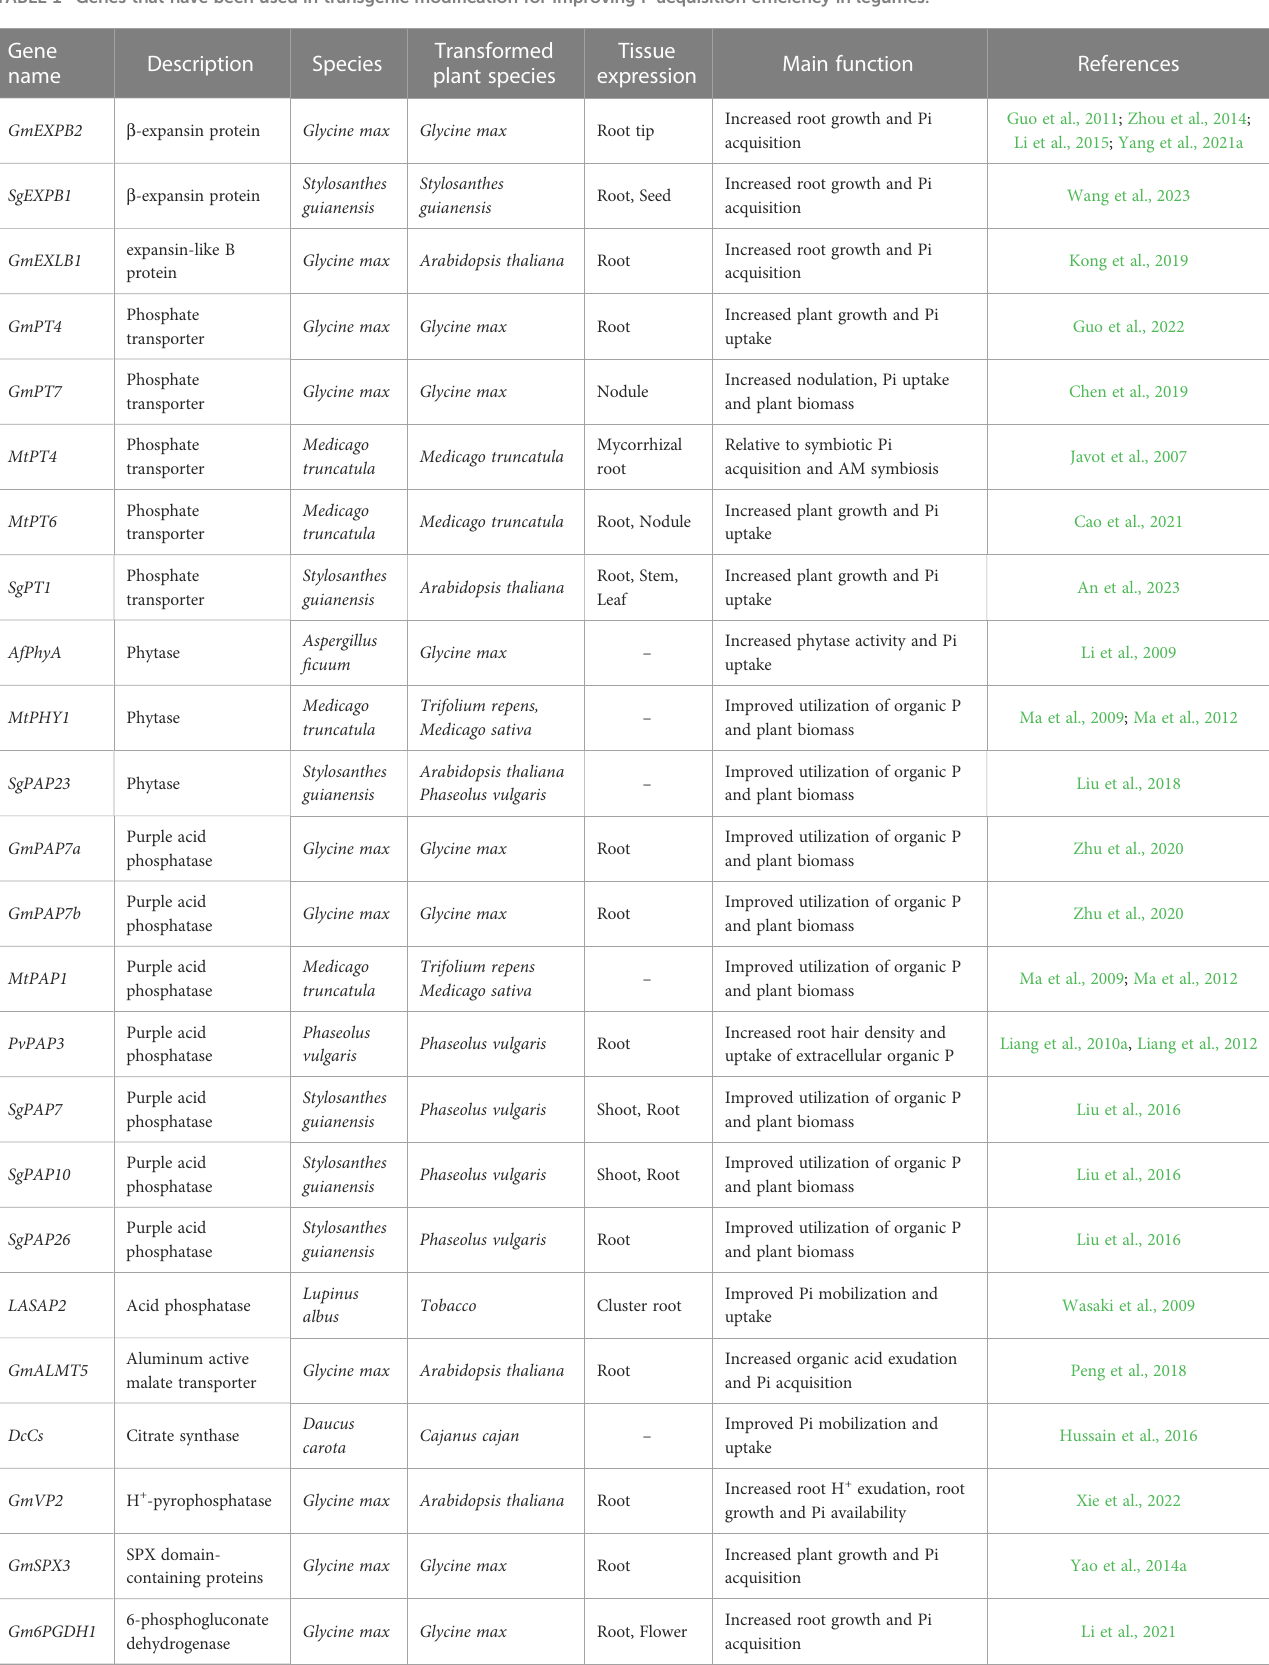
TABLE 1 Genes that have been used in transgenic modi fi cation for improving P acquisition ef fi ciency in